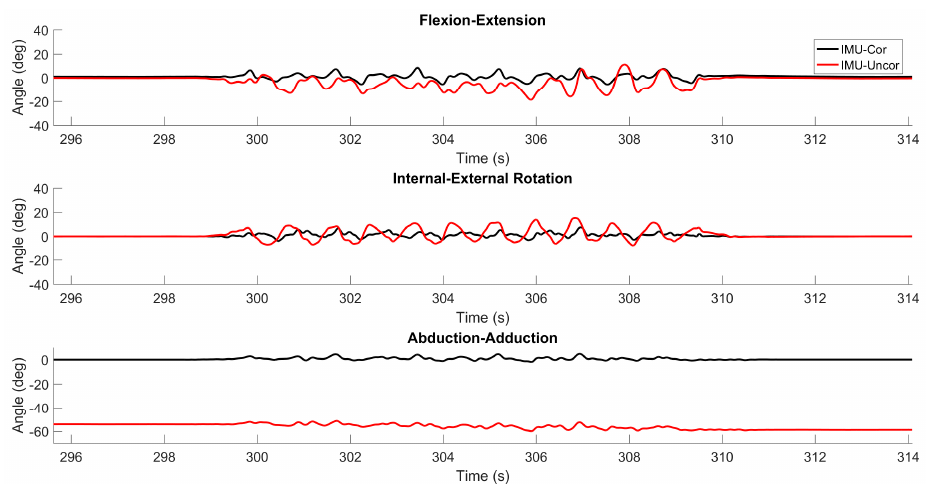
Figure 7. Example results from combined 3D rotation trial. The differences between the CMM truth data and the IMU-derived estimates with the correction (black) and without the correction (red) for flexion/extension, internal/external rotation, and abduction/adduction are plotted for a representative time period.